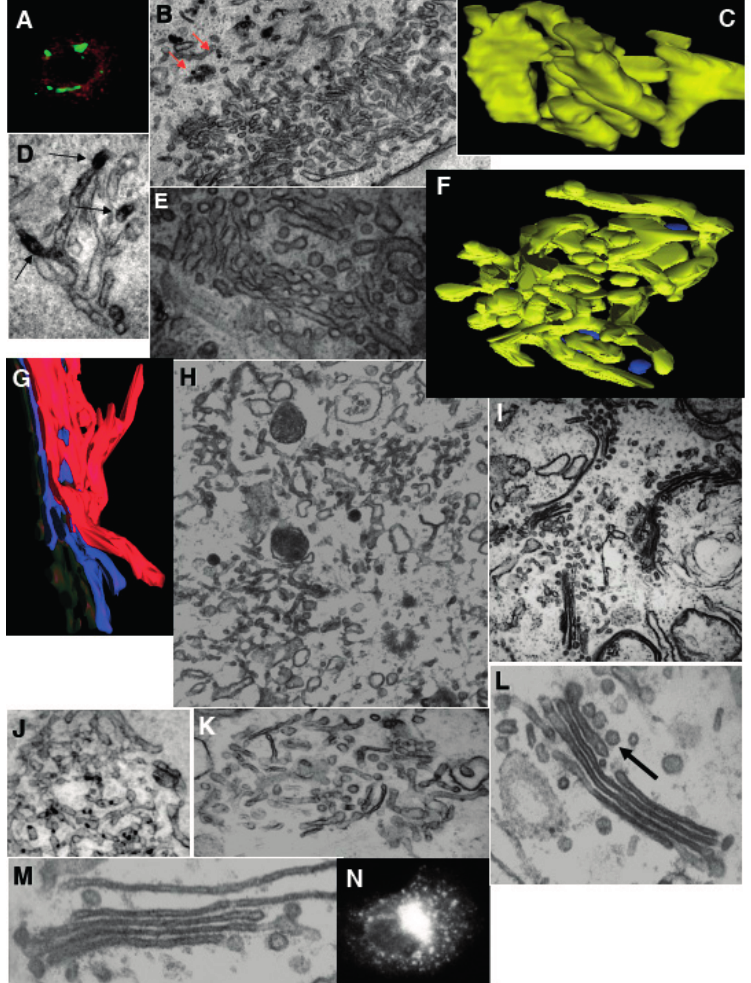
Figure 4. Transformation of Golgi stacks after inhibition of the ATP restoration system, coatomer I (COPI), and the SNARE-proteins. ( A – D ) HeLa cells treated with NZ (5 min) and then BFA + NZ (5 min); ( E ) GA of HeLa cells, 30 min after microinjection of an anti- β COP antibody. ( A ) β COP (red) and ManII (green) labeling; ( B ) labeling of β -COP (nano-gold-enhancement, red arrows); ( C ) Three-dimensional model of the GA; ( D ) immunoperoxidase labeling of ManII (arrows); ( E ) Routine EM section; ( F – N ) Inhibition of membrane fusion or ARF/COPI machine impairs GA shape in permeabilized cells. Ldl F cells were warmed to 40 °C for 6 h ( F ); SLO permeabilized ( G , H ); and incubated for 90 min at 32 °C with the ATP restoration system (ARS), GTP, plus native ( I , K ); COPI-depleted ( J , K , N ) or ARF-depleted ( M ) cytosol, with an anti- β COP antibody ( K ), partially purified COPI cytosol ( K , N ), or mARF1 ( M ), and then prepared for EM. ( F , G ) Three-dimensional tomographic models; ( H , I – M ) Routine electron microscopic sections. ( N ) Immunofluorescence. Arrow in ( L ) shows the section of COPI vesicle. Bars, 10 µm ( A , N ); 400 nm ( B , H , I – K ); 70 nm ( C , G ); 100 ( F ); 120 nm ( D , E , L , M